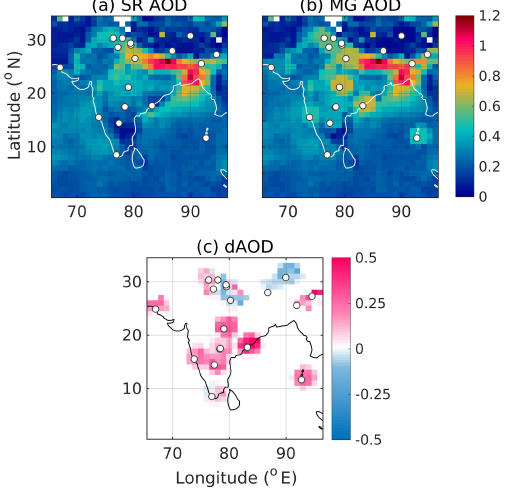
Figure 8. Spatial variation of monthly mean SR AAOD (a) , MG AAOD (b) and dAAOD (c) for January 2009.